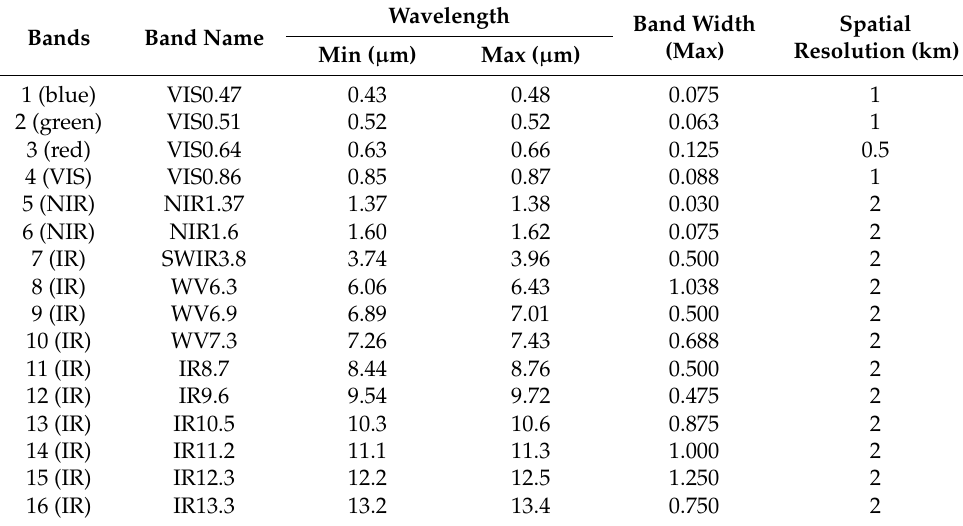
Table 1. Summary of the GEOKOMPSAT-2A (GK-2A)/Advanced Meteorological Imager (AMI) spectral